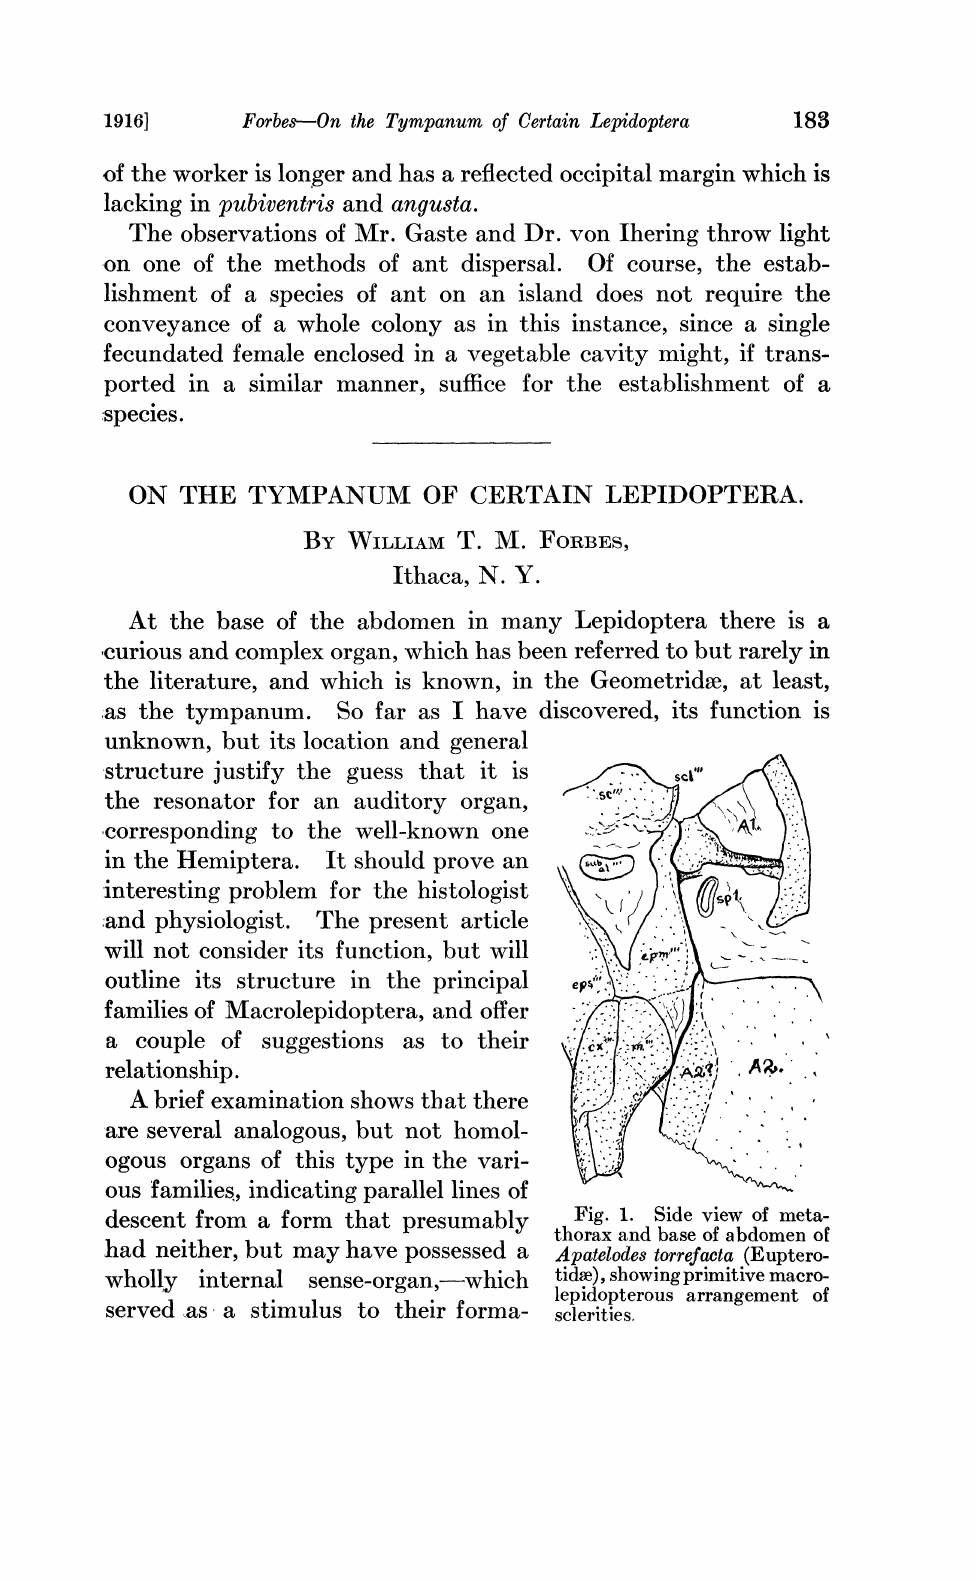
Fig. 1. Side view of meta- thorax and base of abdomen o[ A patelodes torref acta (Euptero- ridge), showing primitive macro- lepidopterous arrangement of